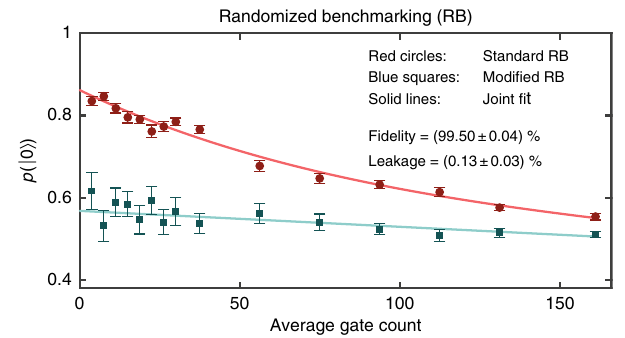
Fig. 3 Characterization of optimized gate sets. The overall fi delity of a gate set consisting of 36 ns long π /2 x and π /2 y gates is determined using RB (red) after a speci fi c calibration run. Each data point is an average over 50 randomly chosen sequences of the respective length, the error bars indicate the standard error of the mean. In order to determine incoherent gate leakage we supplement the standard protocol (red) by a variant, which omits the last inversion pulse (blue) 28 . Simultaneously fi tting both curves yields F ¼ 99 : 50 ± 0 : 04 % and a leakage rate L ¼ 0 : 13 ± 0 : 03 % . For this measurement, Δ B z was stabilized with a standard deviation of